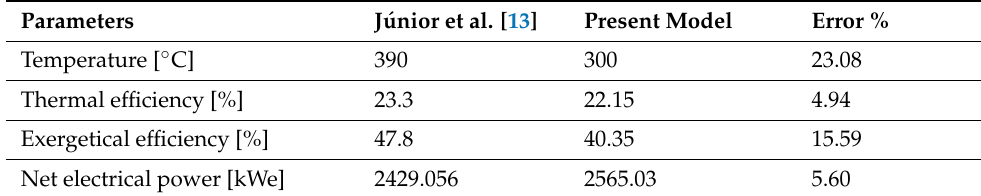
Table 14. Error in the